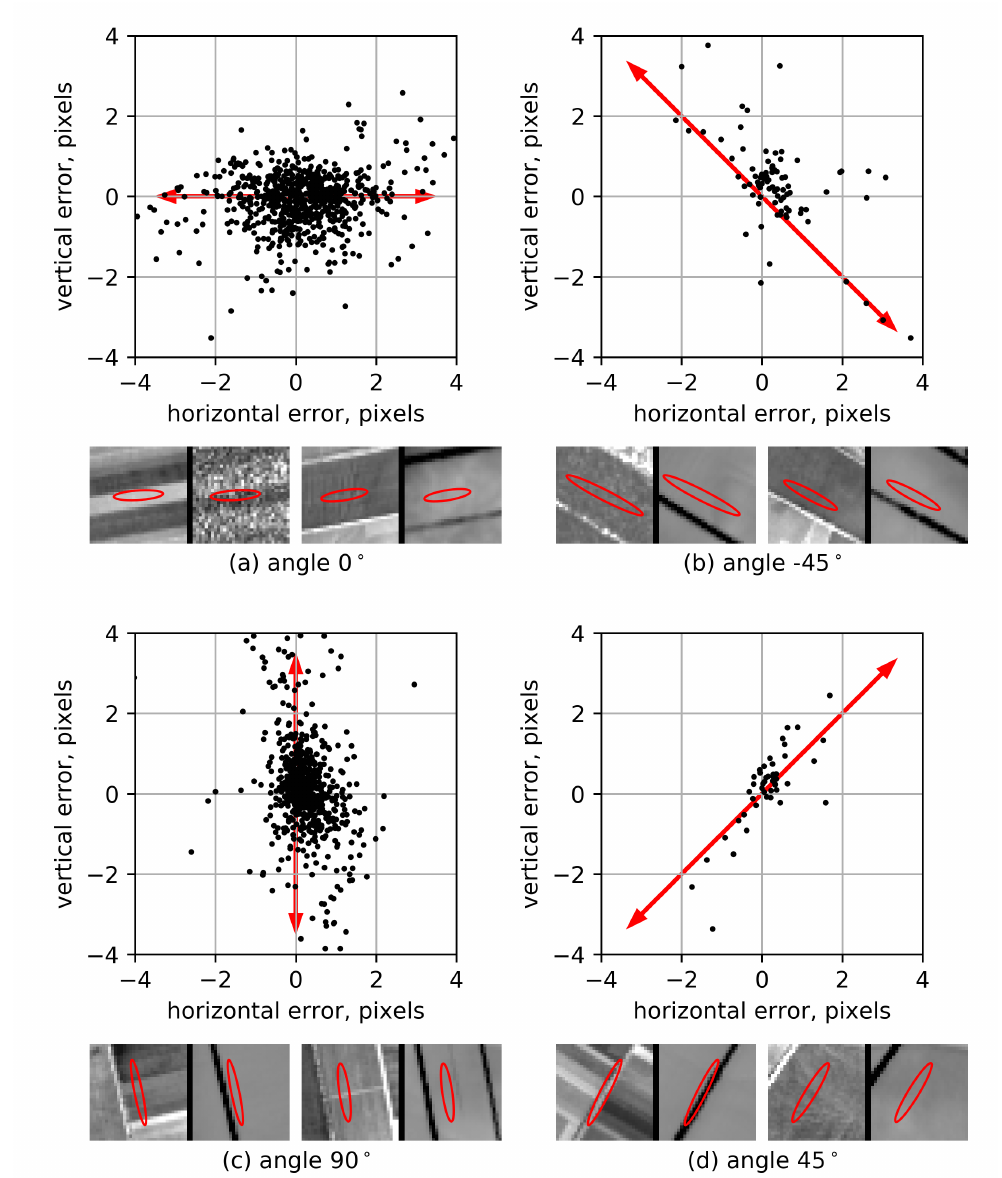
Figure 7. DLSM translation prediction errors grouped together. Each panel corresponds to a specific deviation ellipse orientation (the major axis is marked as double headed error): ( a ) α cov = 0 ◦ , ( b ) α cov = − 45 ◦ , ( c ) α cov = 90 ◦ , and ( d ) α cov = 45 ◦